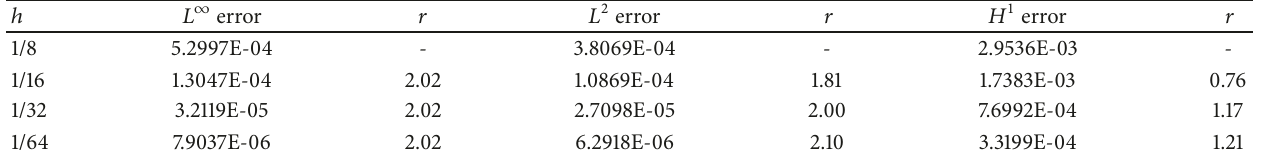
Table 5: Errors of the state for different error